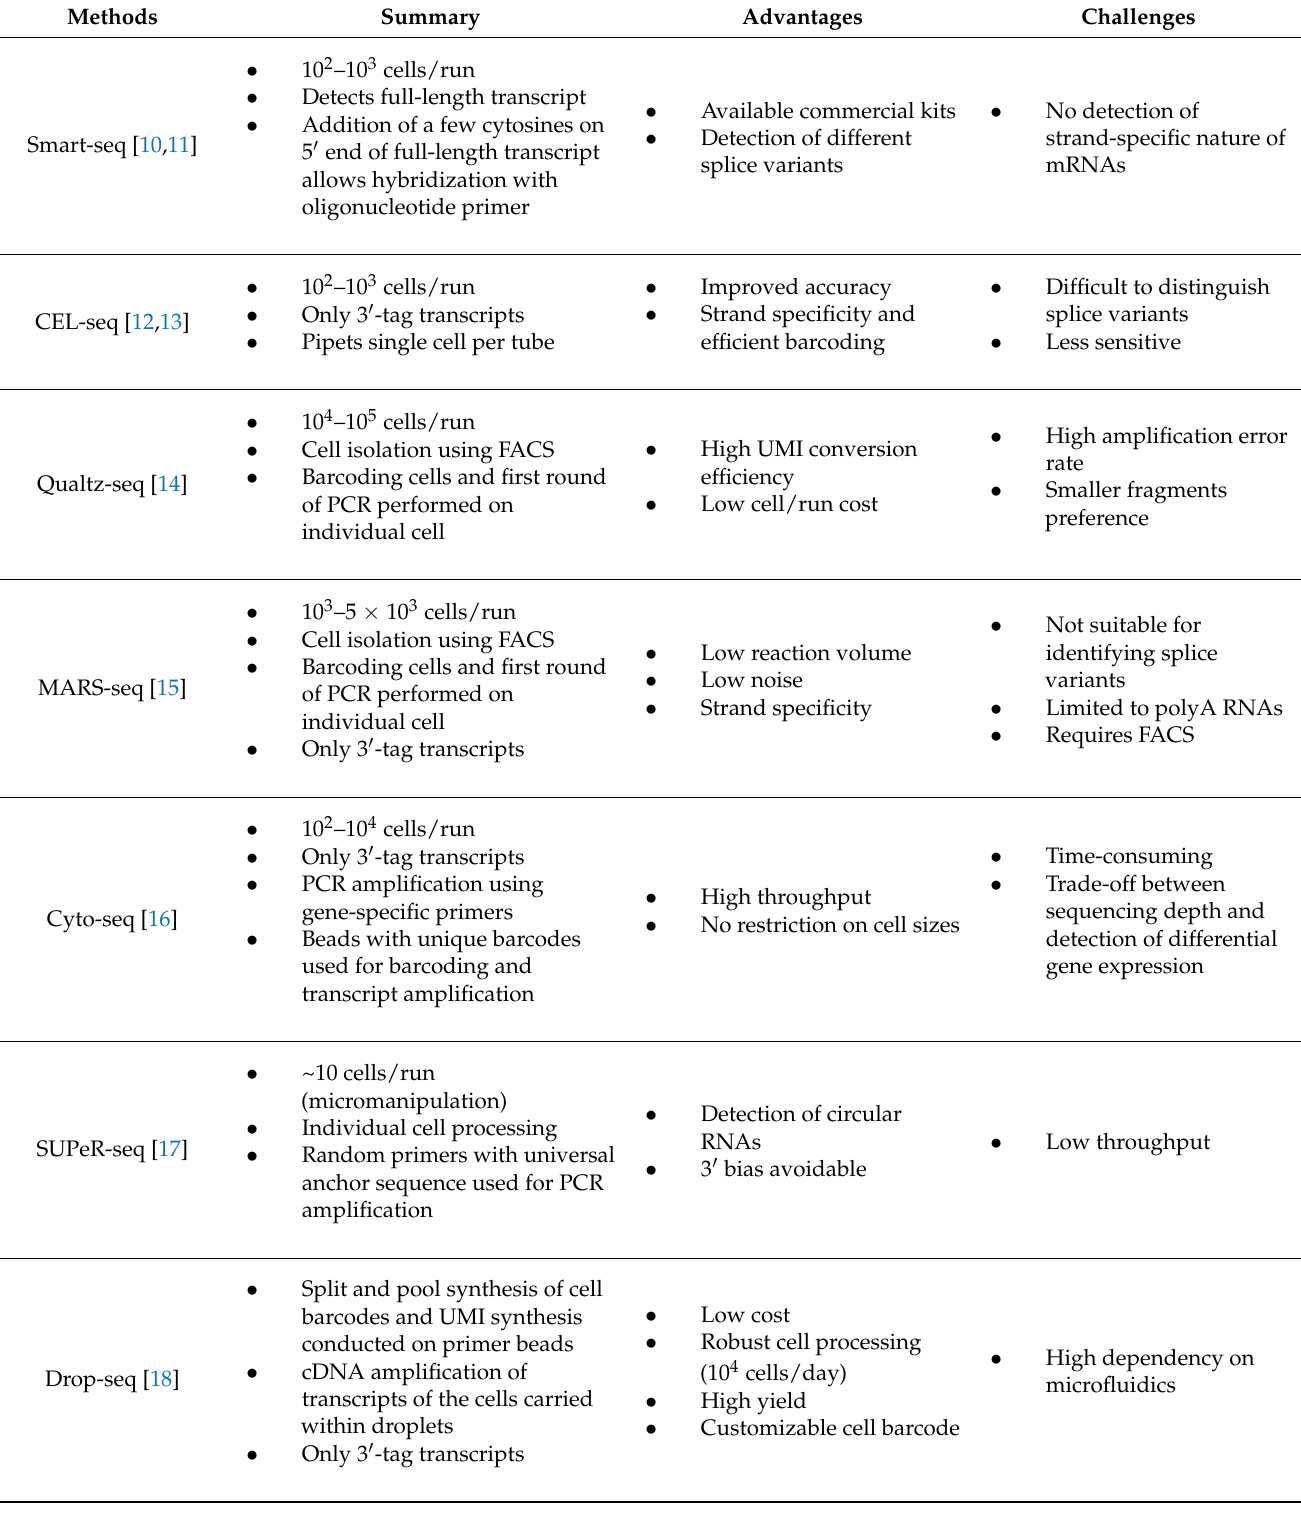
Table 1. Summary of technical features of the scRNA-seq methods described in the